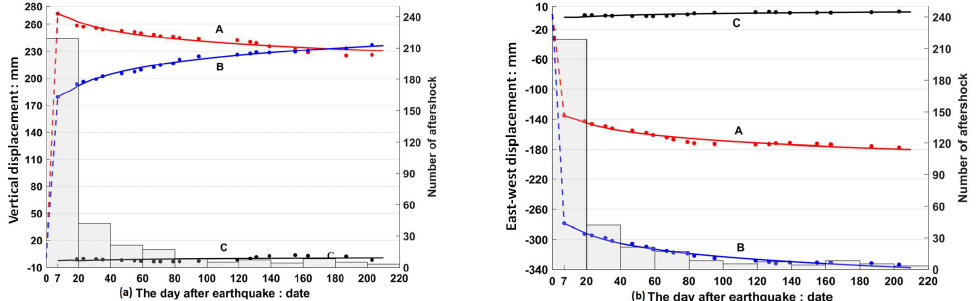
Figure 11. Time series of the cumulative deformation. ( a ) Up-Down (UD) and ( b ) EW deformation. Red indicates Patch A. blue indicates Patch B. and black indicates Patch C. The dotted line indicates co-seismic deformation. Points indicate the cumulative deformation time series of the post-seismic deformation. The solid line indicates the fit of the cumulative deformation time series to the post-seismic deformation. The left Y axis represents the deformation, the right Y axis represents the number of aftershocks, and the X axis represents the number of days after the